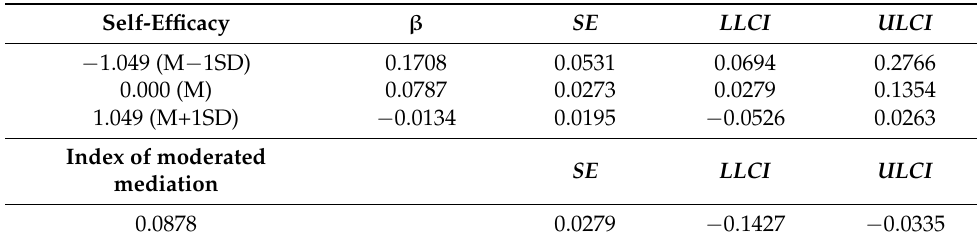
Table 8. Conditional effects according to vocational calling.